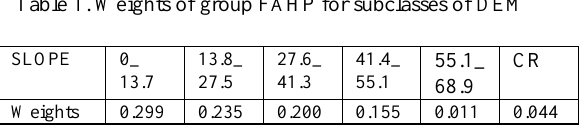
Table 1. Weights of group FAHP for subclasses of DEM